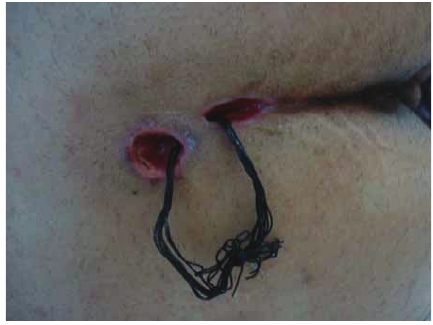
Figure 2: The sutures in the sinus tract cavity.